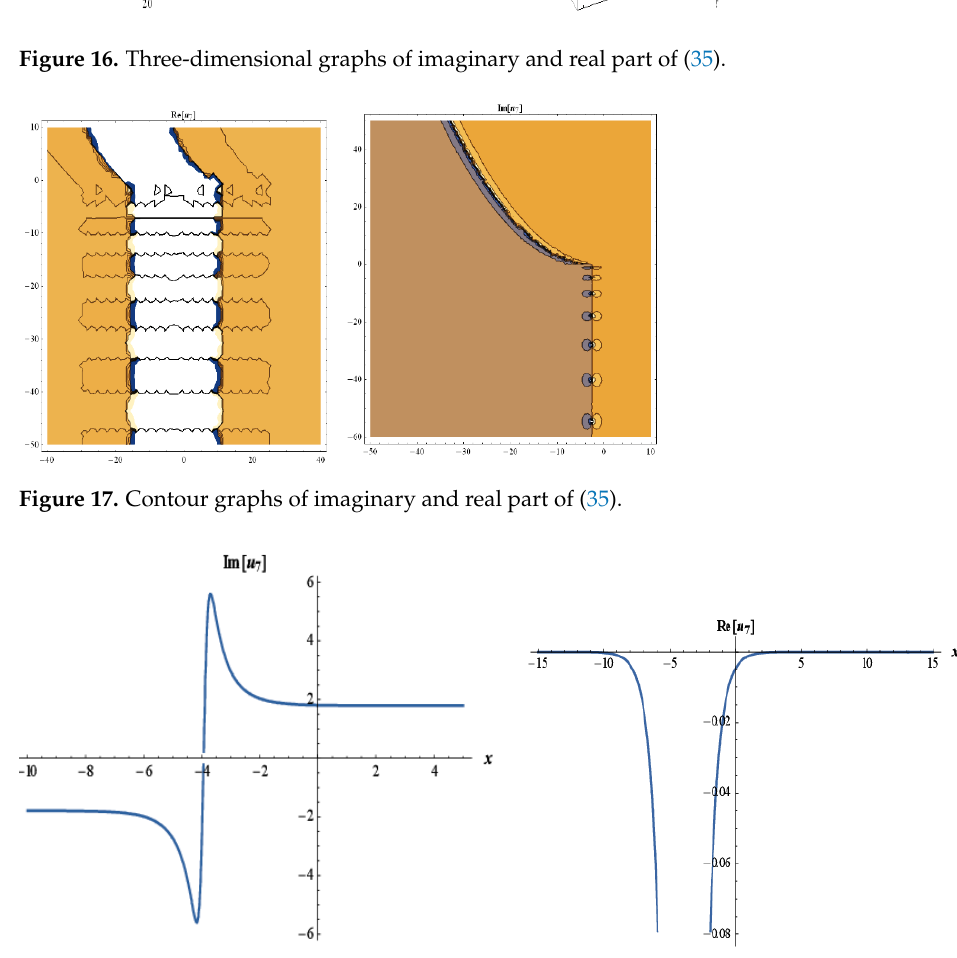
Figure 18. Two-dimensional graphs of imaginary and real part of